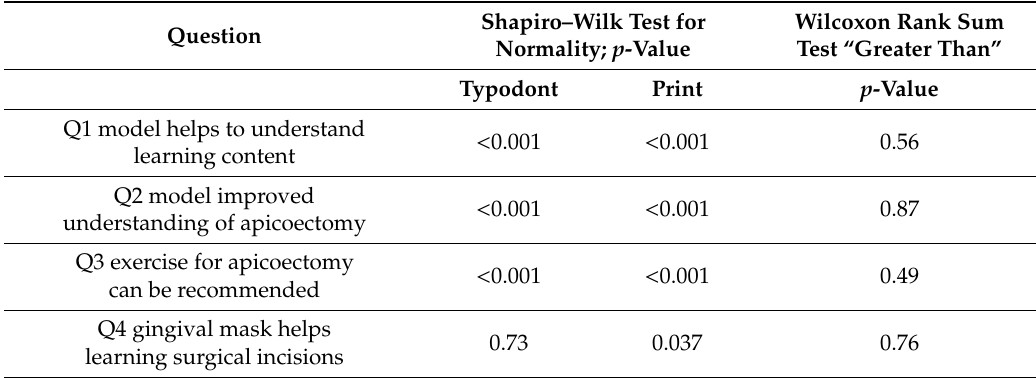
Table 1. Results of Shapiro–Wilk tests for normality of ratings and of Wilcoxon rank sum tests for significant differences between ratings for both model types (alternative hypotheses: true location shift between ratings of typodont model and 3D-printed model is greater than 0).